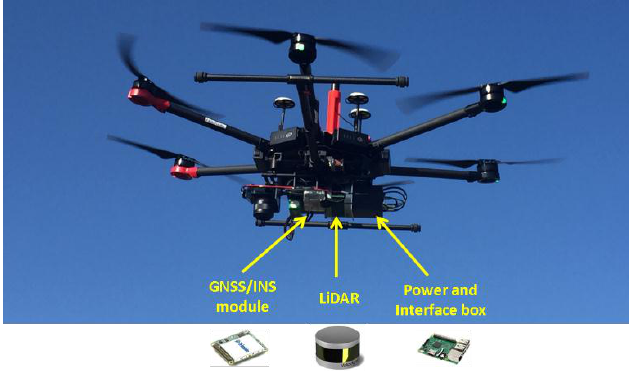
Figure 1. UAV-based mapping system configuration.